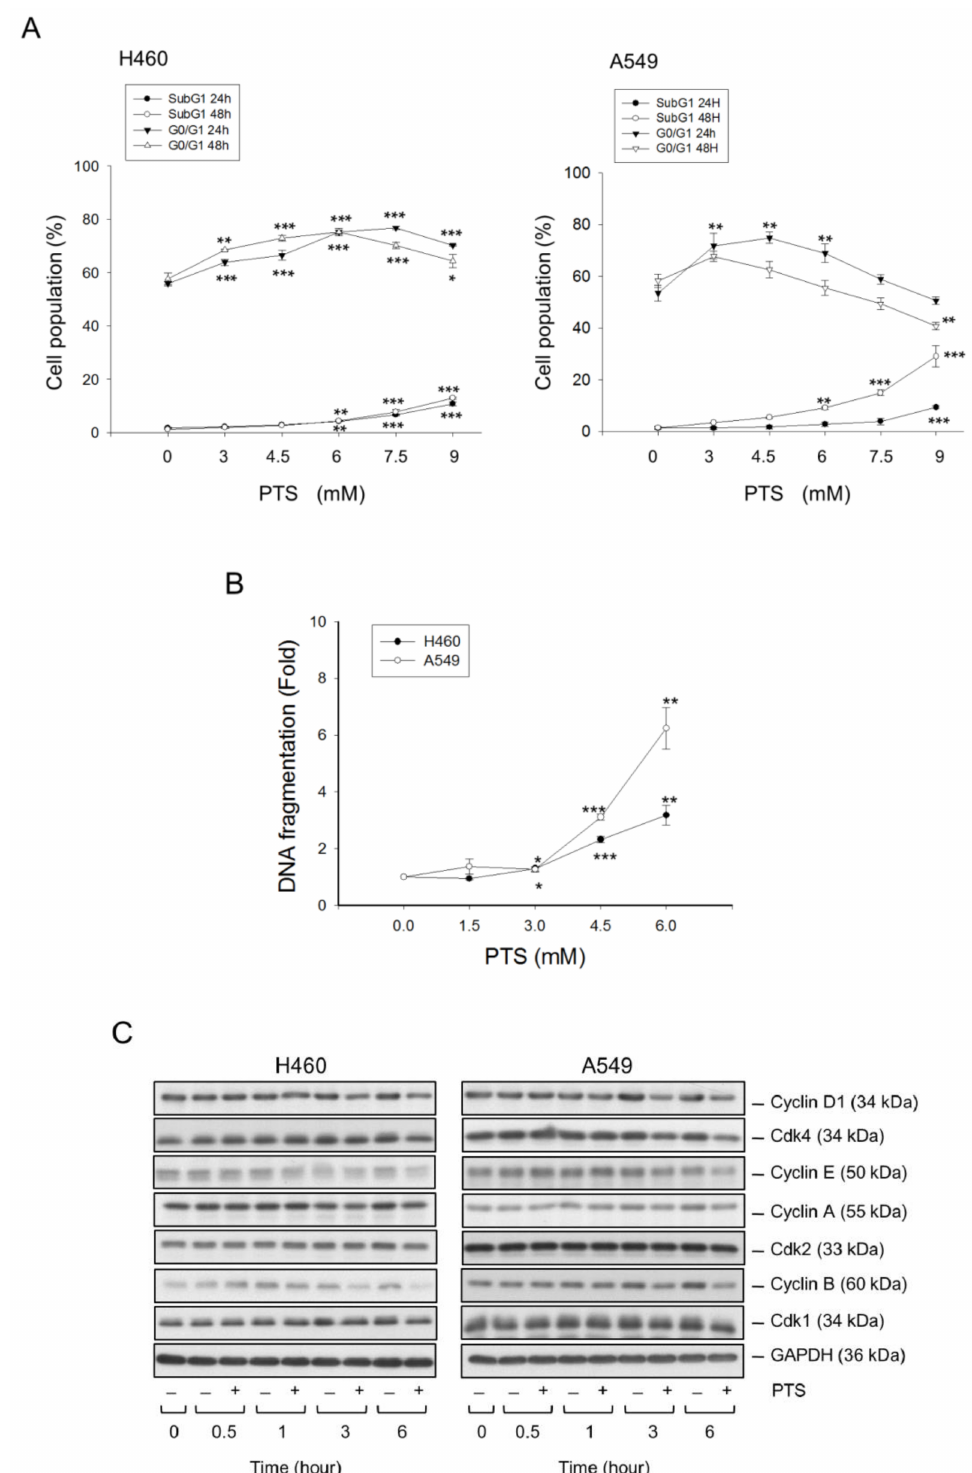
Figure 2. Effect of para -toluenesulfonamide on the distribution of cell cycle phases in NCI-H460 and A549 cells. The cells were incubated in the absence or presence of para -toluenesulfonamide at the indicated condition ( A , 24 and 48 h; B , 48 h; C , 6 mM). After the treatment, the cells were harvested for the detection of cell population at different phases by flow cytometric analysis of PI staining ( A ), the cell apoptosis by detecting nucleosomal DNA fragmentation using Cell Death Detection ELISA PLUS kit ( B ) and the detection of protein expressions of cell cycle regulators by Western blot analysis ( C ). Quantitative data are expressed as mean ± SEM of three independent experiments. * p < 0.05, ** p < 0.01 and *** p < 0.001 compared with the